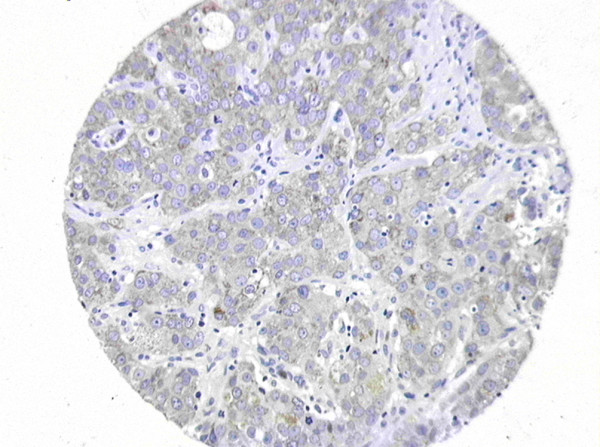
Tissue microarray core demonstrating tumour with weak Lewisy/b expression. Seventy percent of breast tumours showed weak expression of Lewisy/b using SC101.